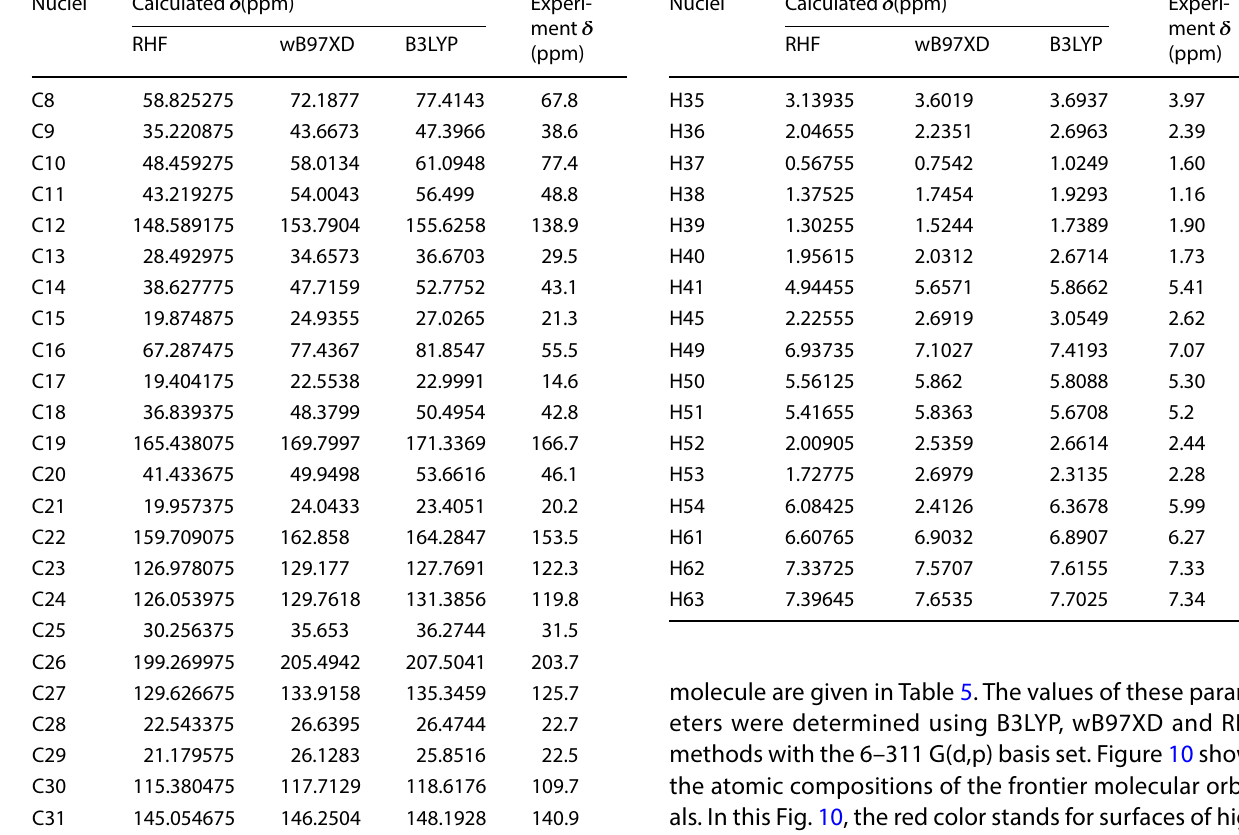
Table 4 Experimental [9] and calculated 1 H NMR chemical shift 𝛿 (ppm) of andirobin at the RHF, B3LYP and wB97XD method with 6–311 G(d,p) basis set Nuclei Calculated 𝜹